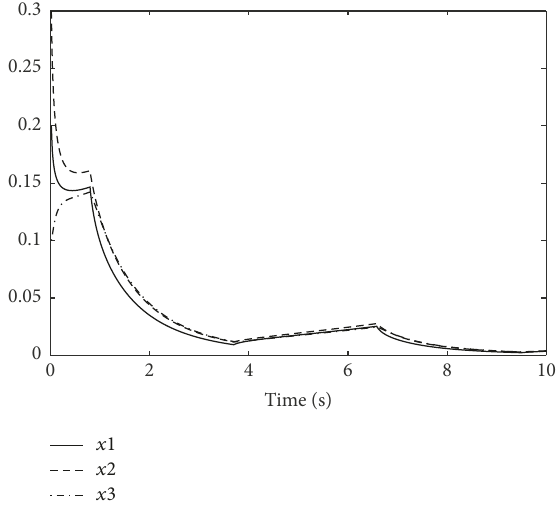
Figure 1: State trajectories of closed-loop system (5).